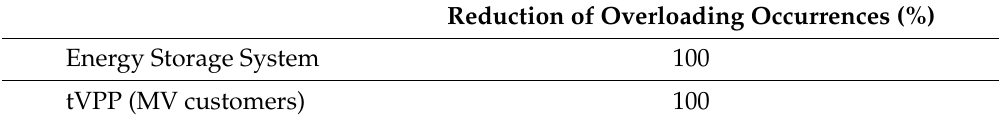
Table 2. KPIs—Portuguese overloading